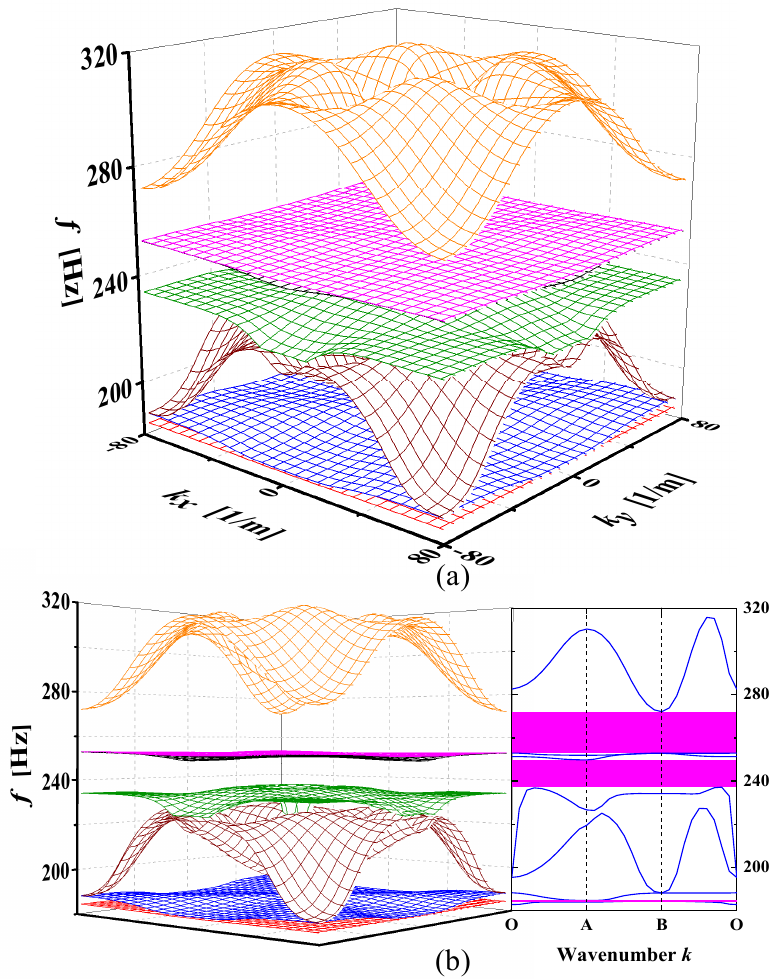
Figure 5. ( a ) Dispersion relations for SHAMLRAS structures in isometric perspective; ( b ) comparison of dispersion relations and band structure in horizontal view.